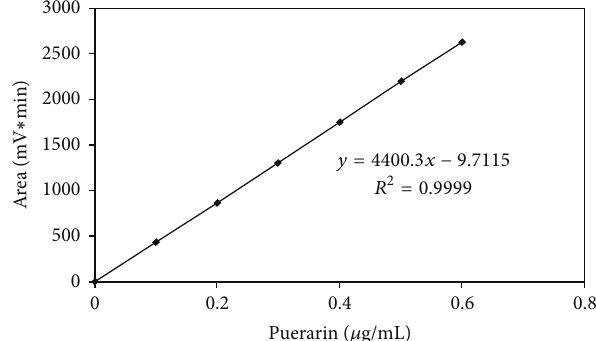
Figure 1: Standard puerarin calibration curve. The data were reported as means ± standard